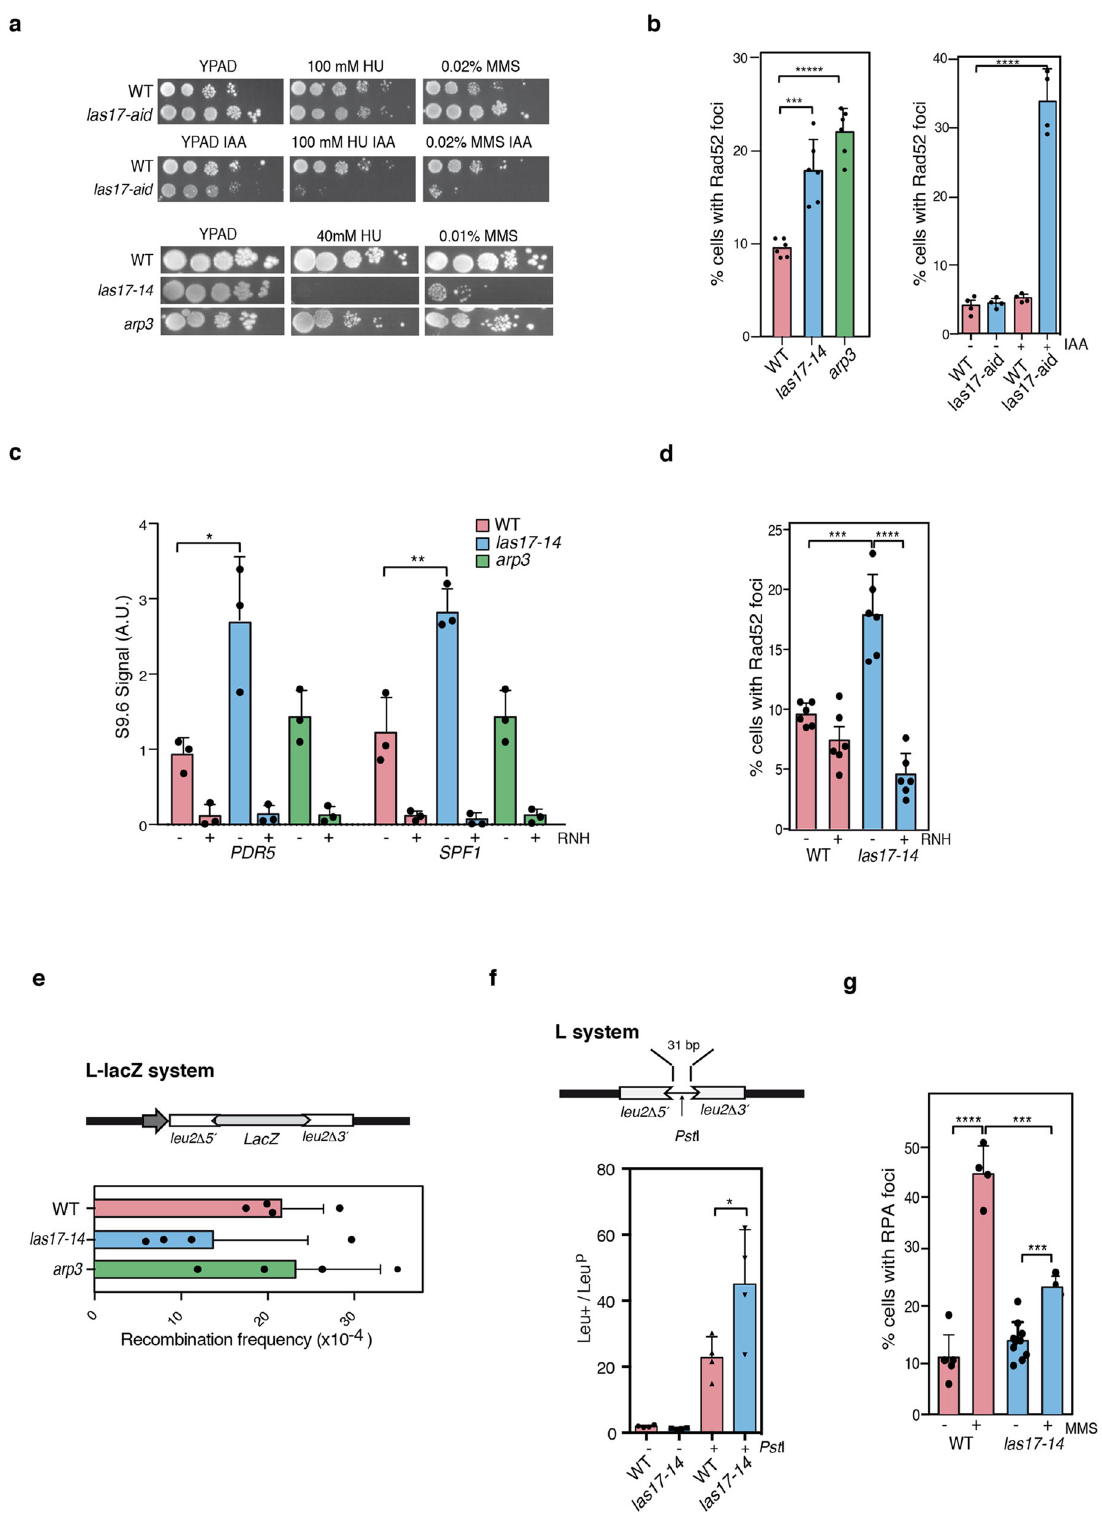
Next, to directly test how the Las17 protein may in fl uence HDR, we analyzed recombination by single-strand annealing deletion events in the plasmid-born recombination system L-lacZ based on two 0.6-kb leu2 repeats with a 3-kb lacZ sequence in between (Fig. 6e). Notably, we found that the frequency of recombination in las17-14 mutant was not higher than that in wild-type yeast (Fig. 6e), which we would have expected if the